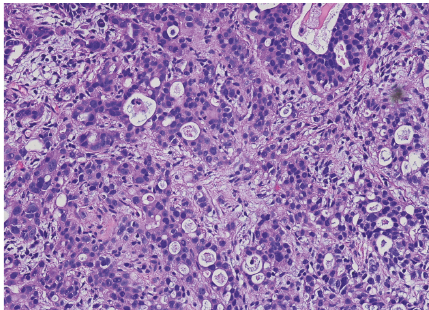
Figure 4: H&E stain of the bladder tumor with morphologically similar cells to the esophagus